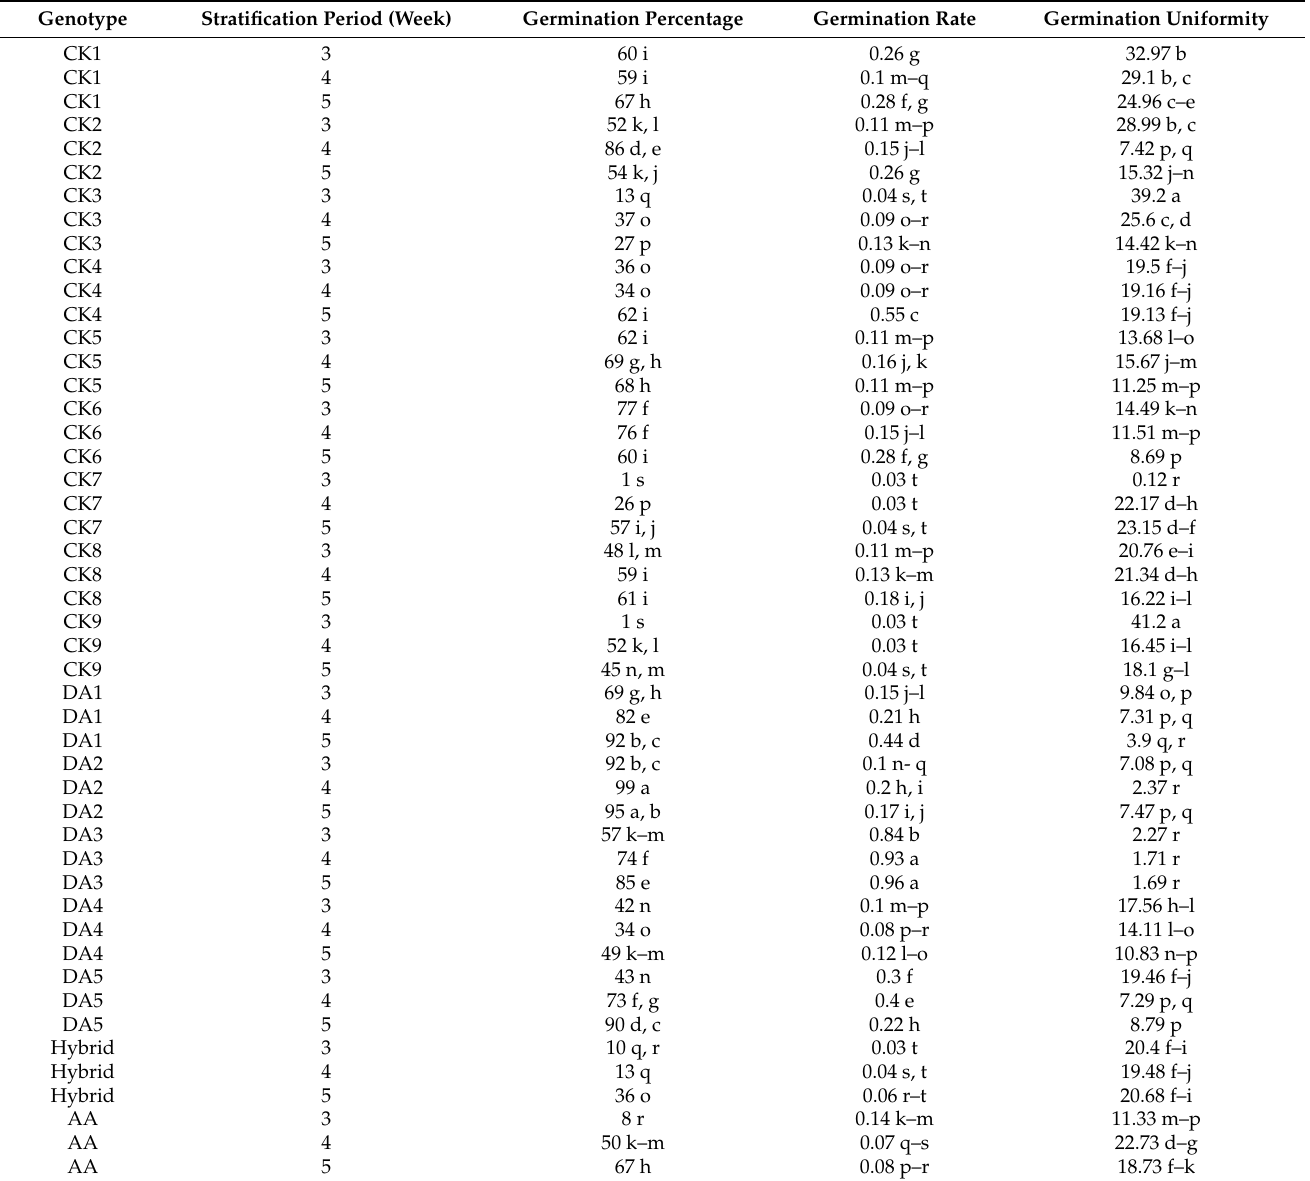
Table 3. Genotype and stratification interaction effects on germination percentage, germination rate and germination uniformity of kiwifruit